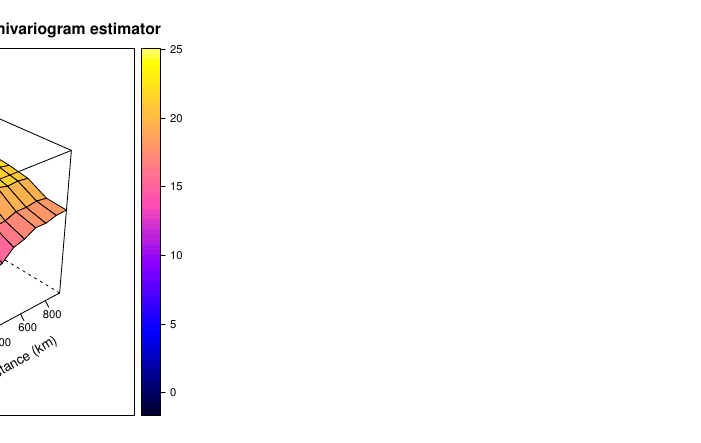
Figure 5. Three-dimensional picture of the Huber spatio-temporal semivariogram estimator (with a tuning constant equal to 1.345) of the daily Tmax from the NOAA data for July 2003 computed using the estimator introduced in Section